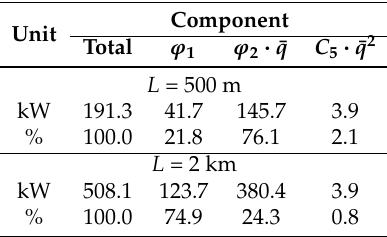
Table 1. Contributions of individual components to the total power required.